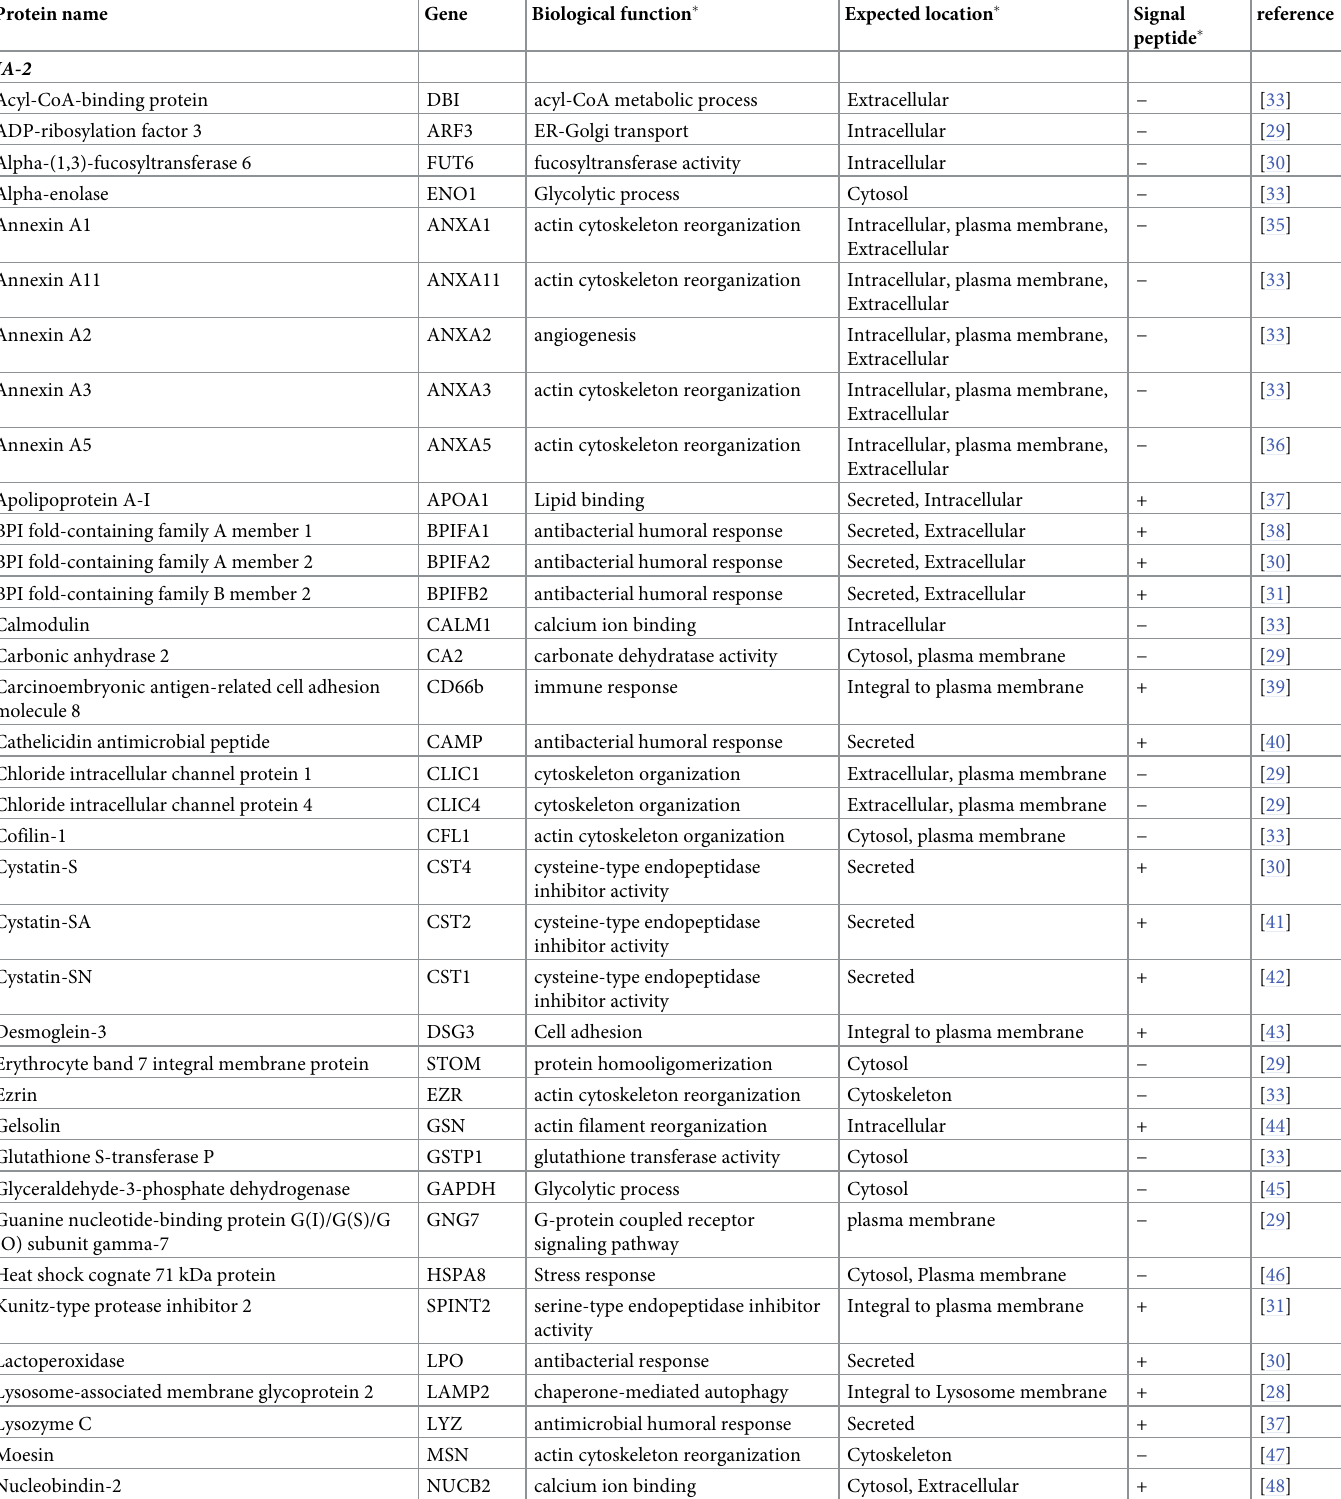
Table 2. List for of proteins classified into